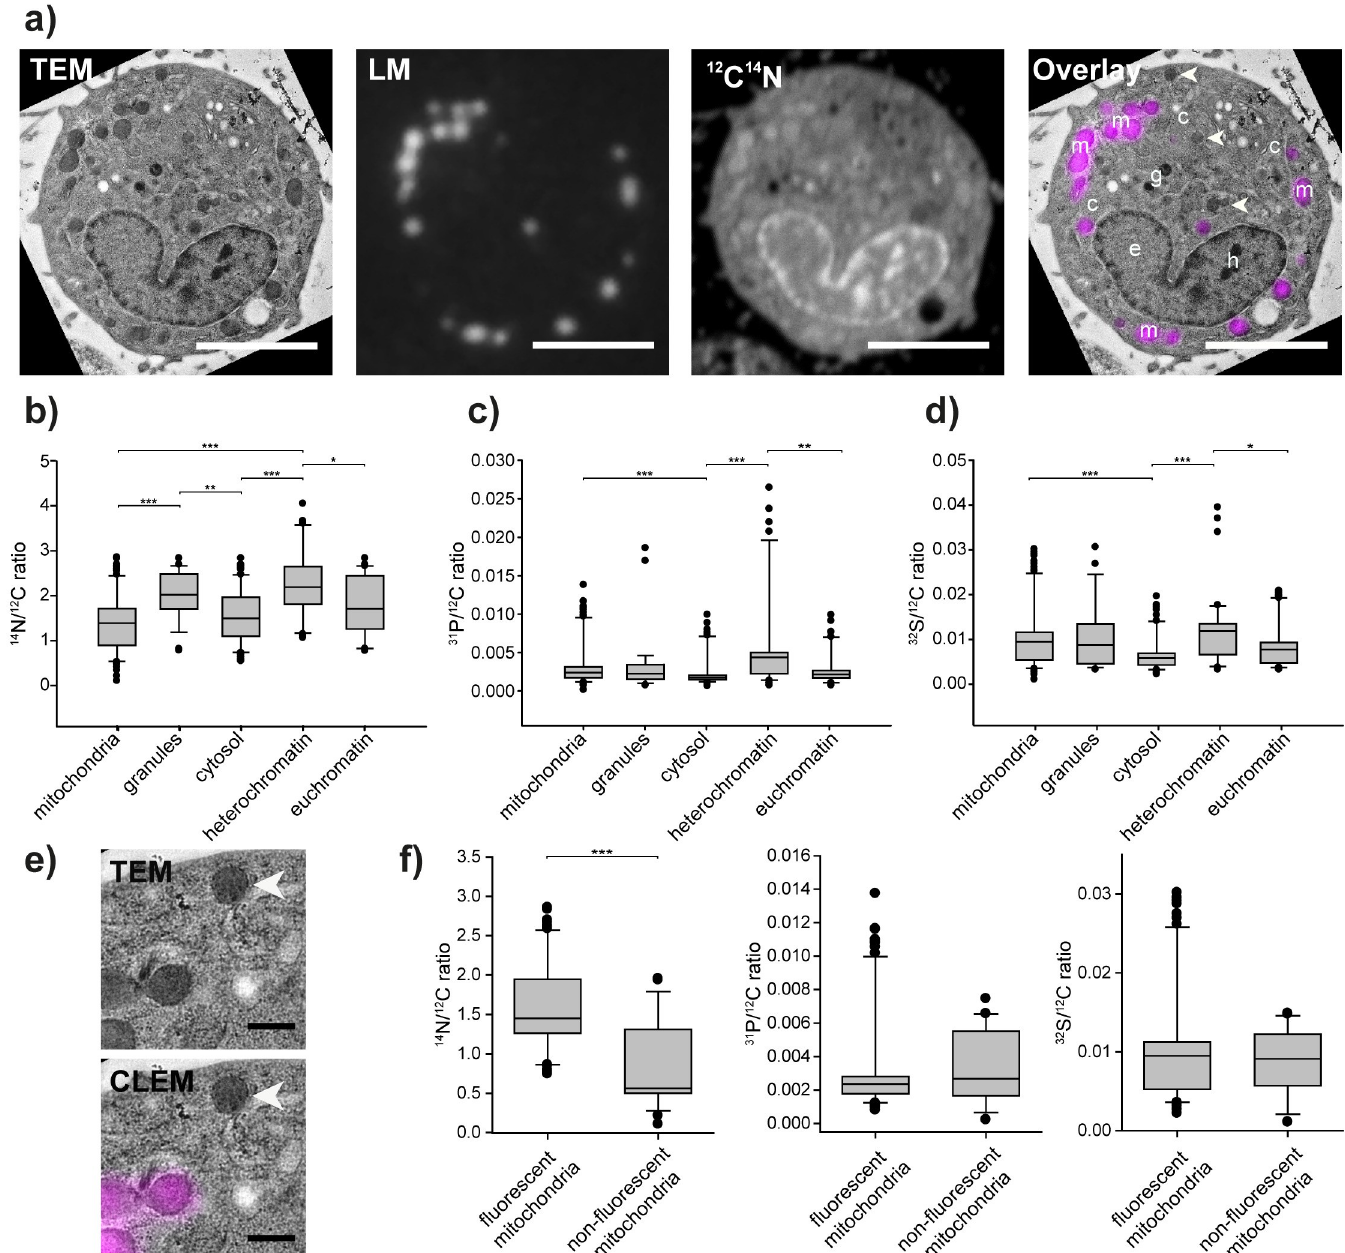
Fig 4. An analysis of cultured cells with CLEM-SIMS shows different isotopic distribution in different cellular compartments. a) CLEM-SIMS images of a cell labeled with MitoTracker (magenta). The overlay combines the TEM and fluorescence images. The arrowheads indicate several mitochondria not labeled by MitoTracker, but visible in TEM. Scale bars: 5 μ m. The letters indicate mitochondria (m), granules (g), euchromatin (e), heterochromatin (h) and cytosol (c). b-d) NanoSIMS analysis of specific compartments in the cells, identified in the TEM images. The graphs show box plots from 34 to 89 cellular regions, from multiple analyzed cells. Ratios of different isotopes to the ubiquitous 12 C (present in the cellular material and in the plastic resin) are shown. The middle line in the boxes indicates the median, while the boxes show the 25 th percentiles; the error bars show the 75 th percentiles, with outliers indicated by the symbols. Statistical differences were tested using Kruskal-Wallis tests, followed by Tukey post-hoc tests; � p < 0.05; �� p < 0.01; ��� p < 0.001. b) 14 N analysis. c) 31 P analysis. d) 32 S analysis. e) A higher zoom view of mitochondria labeled with MitoTracker (magenta) or lacking the label (white arrowhead). Scale bar: 500nm. f) Analysis of the fluorescently-labeled and non-labeled mitochondria. The measurements compare 85 labeled mitochondria and 24 non-labeled ones. Statistical differences were tested using Mann-Whitney tests; ��� p < 0.001.